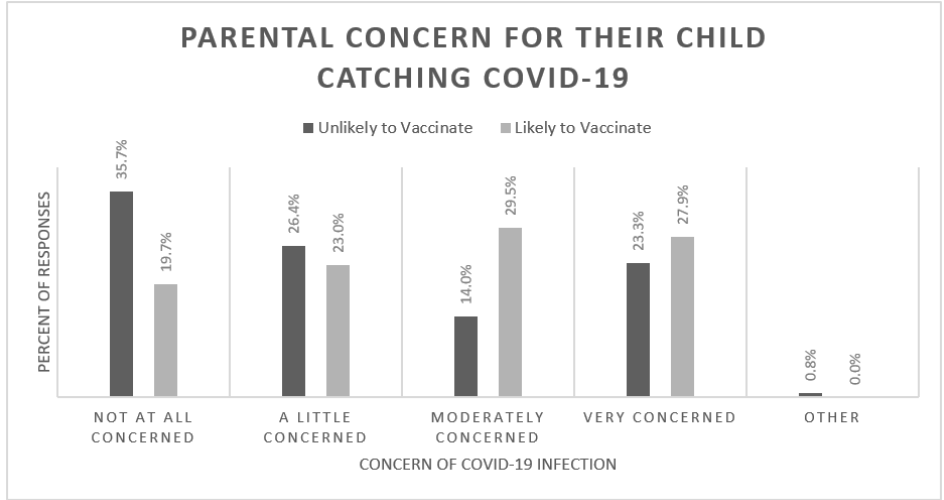
Figure 3. Bar chart displaying the percentage of responses versus parental concern for their child catching COVID-19. There was a statistically significant difference between the two groups ( p = 0.012). Possible future motivating reasons (i.e., would allow vaccination to protect the health of my child/friends/family/community, to get back to travel/school/work) were evalu- ated to see what could motivate a hesitant parent to agree with vaccination. The presence of a positive motivational reason in a parent/guardian was significantly higher when they were ‘likely to vaccinate’ relative to those who were unlikely. 50% (66/131) of ‘unlikely to vaccinate’ individuals would allow vaccination if it meant protection of their